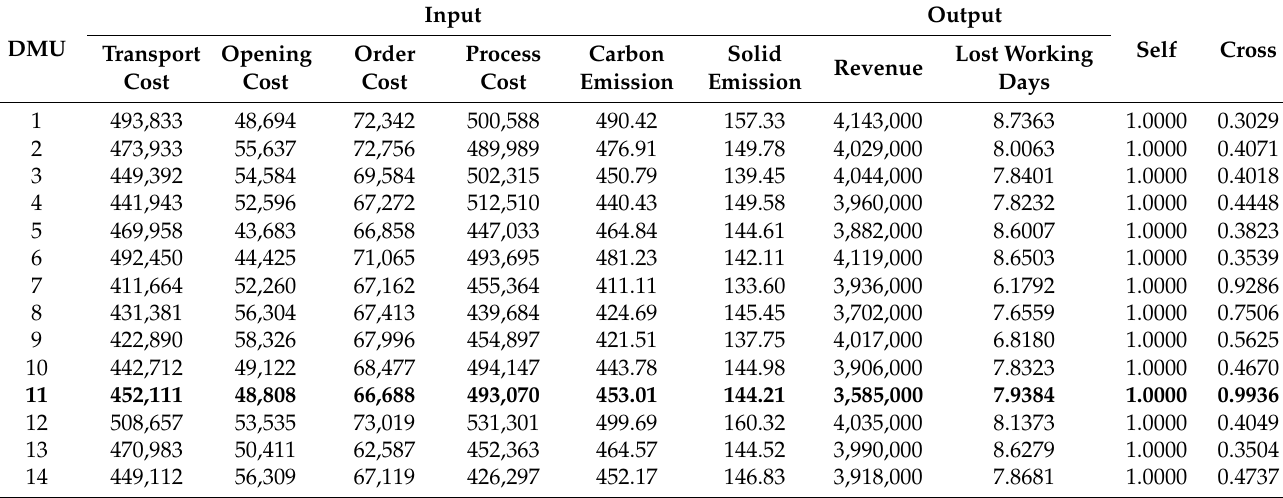
Table 5. Indicators and efficiency values calculated by SG-MOPSO.